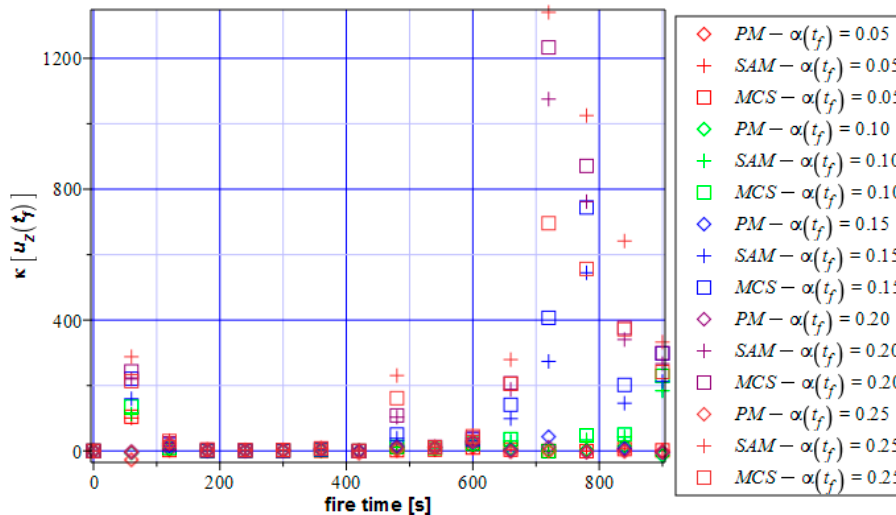
14 of 21 Figure 12. Coefficient of the variation of the vertical deflections.